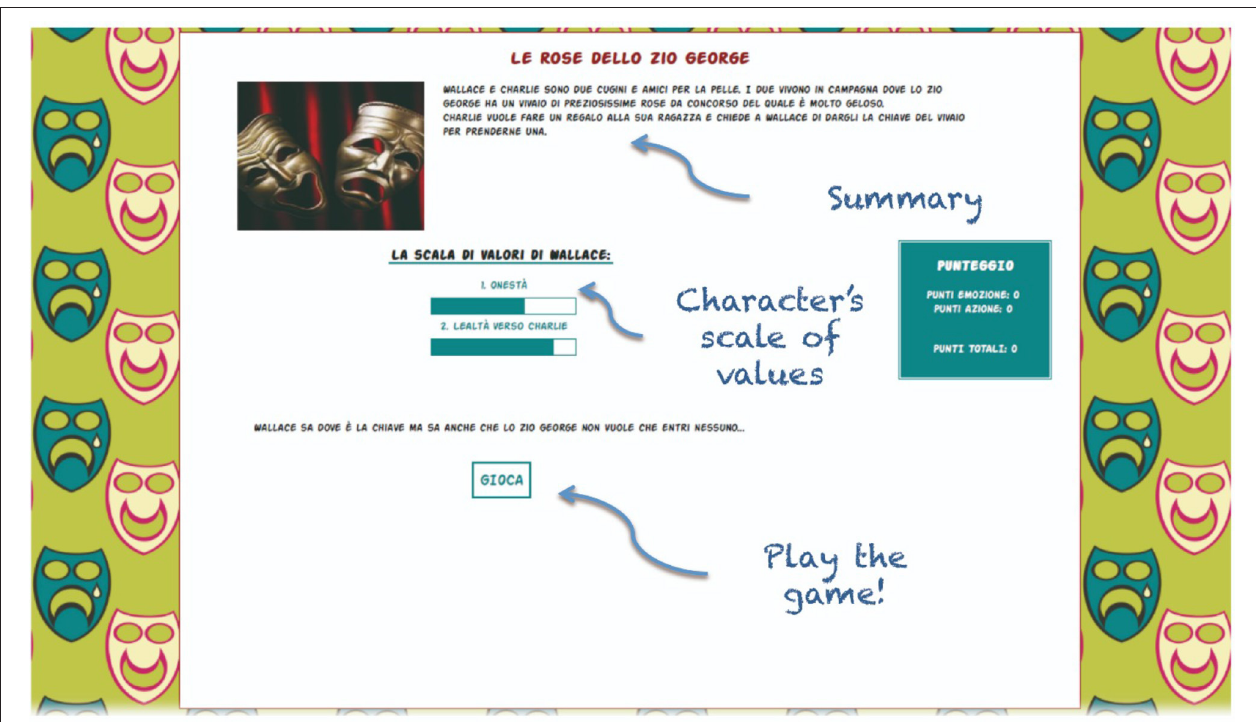
FIGURE 2 | The screenshot of the online interface of the Actor Studio test (in Italian).